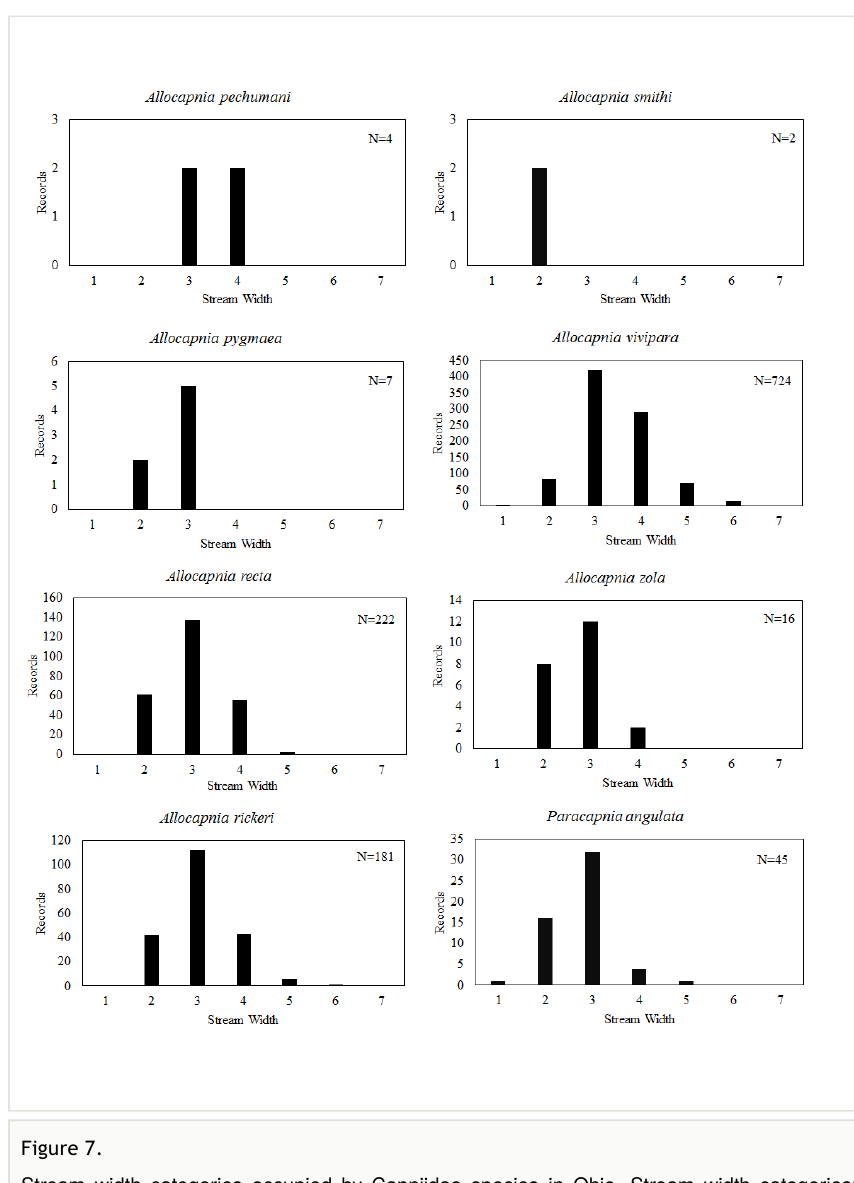
Figure 7. Stream width categories occupied by Capniidae species in Ohio. Stream width categories: 1=seep, 2=1-2 m, 3=3-10 m, 4=11=30 m, 5=31-60 m, 6=>60 m, 7=Lake